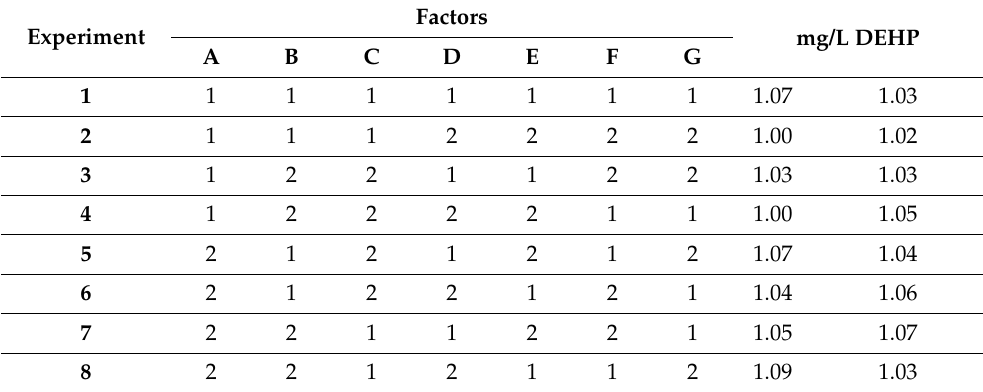
Table 7. Experimental design of five-parameter two-level factors, to evaluate the ruggedness of method (according to Taguchi experimental design, seven-parameter two-level factors). Experiment